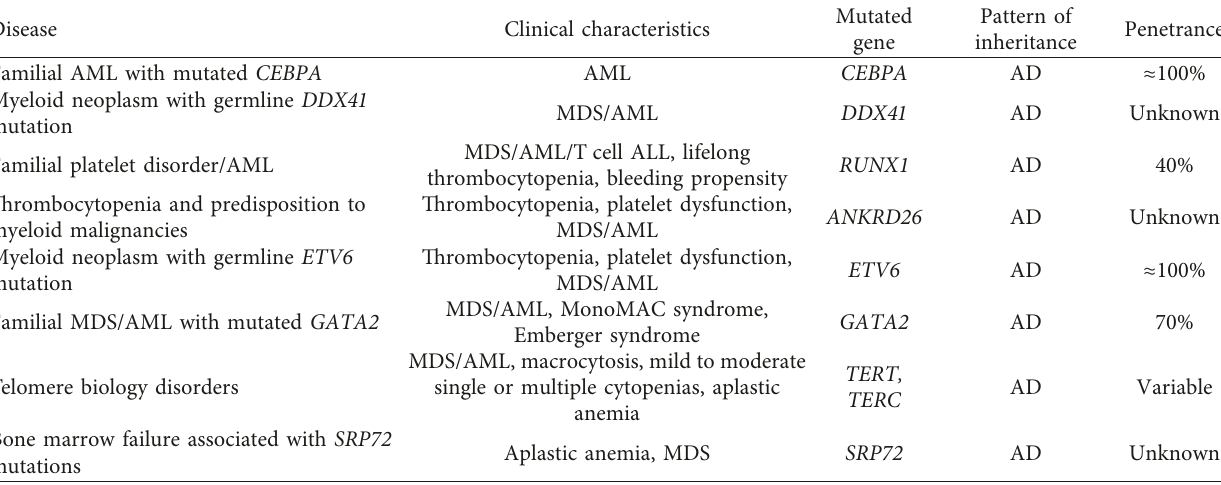
Table 2: Characteristics of AML/MDS predisposition